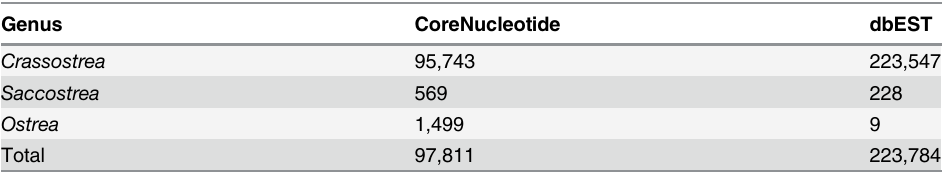
Table 1. Total numbers of nucleotide and EST sequences for the oyster genera Crassostrea , Saccostrea and Ostrea in GenBank via NCBI (as at July, 2013) that candidate sequences were searched against in the current